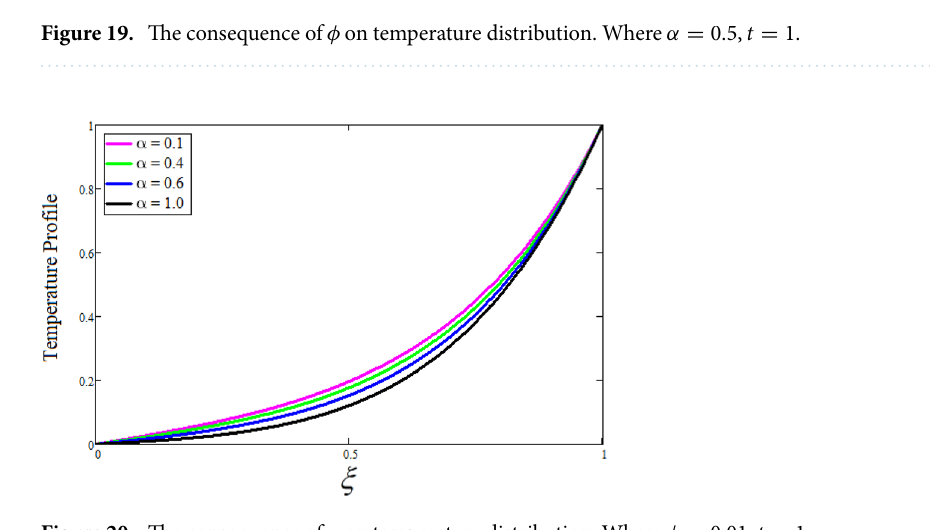
Figure 20. The consequence of α on temperature distribution. Where φ = 0.01, t =